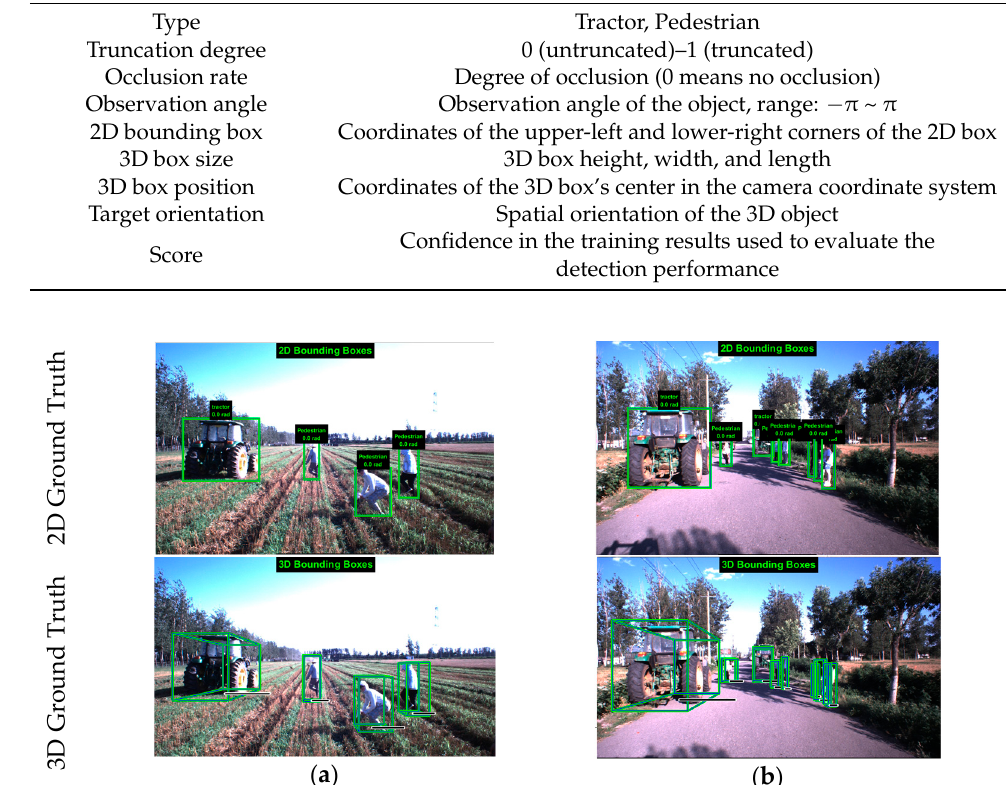
Figure 4. Visualization of annotated ground truth: The first row is the annotated 2D ground truth, and the second row is the projection of the annotated 3D ground truth onto the image. ( a ) Field scene; ( b ) Agricultural road scene. ( a ) shows the ground truth of obstacle labeling in the field scene, while ( b ) shows the ground truth of obstacle labeling in the agricultural road scene.